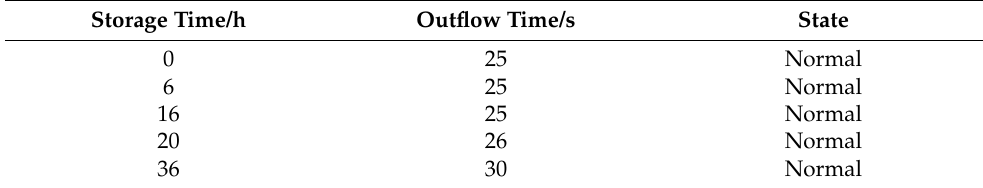
Table 1. Outflow times of WB zinc-based paints after storage for different times.